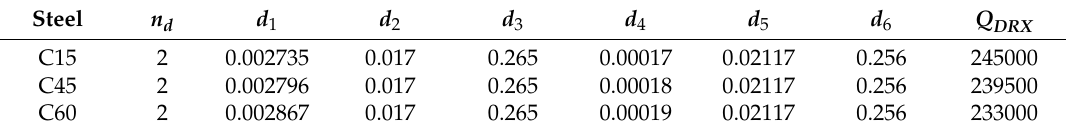
Table 5. Model coefficients for dynamic recrystallization.